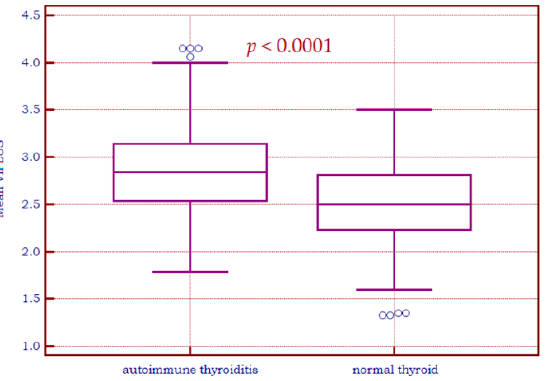
Figure 5. Box-and-whisker distribution plots representing Vi PLUS values in patients with autoim- mune thyroiditis versus patients with a healthy thyroid.